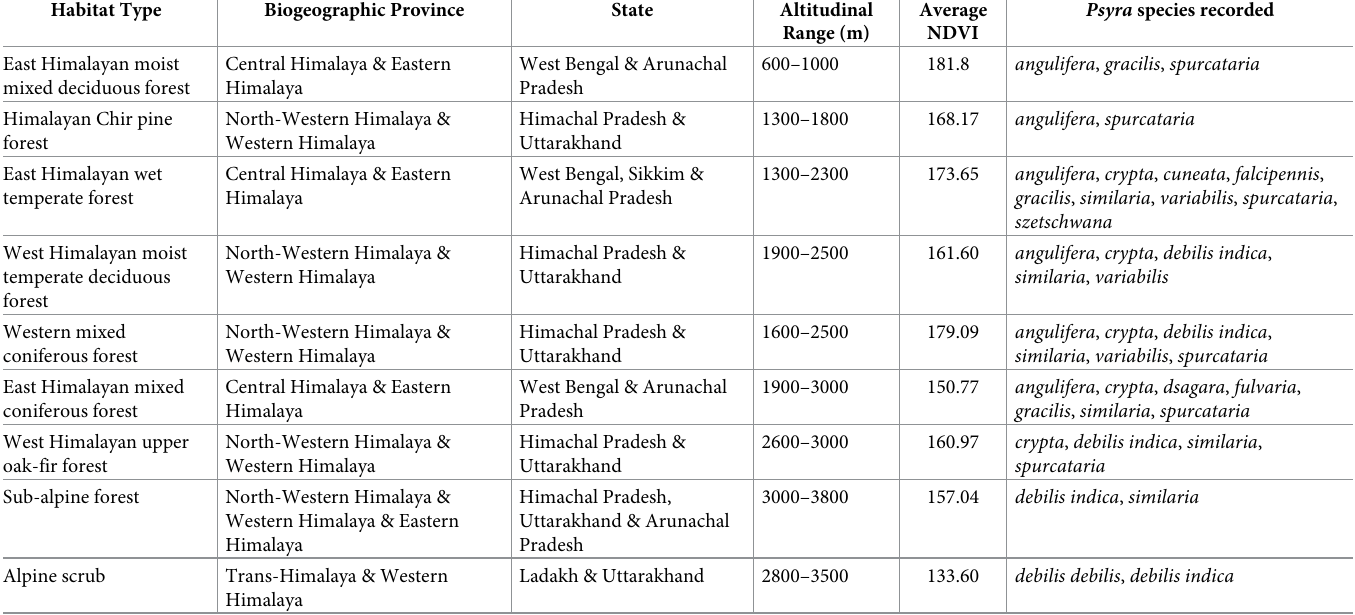
Table 1. Major habitat types in different biogeographic provinces of the Indian Himalaya with their respective altitudinal range, average Normalized Difference Vegetation Index (NDVI) values and Psyra species recorded during sampling period of 2010–2012 and 2016–2019. Habitat Type